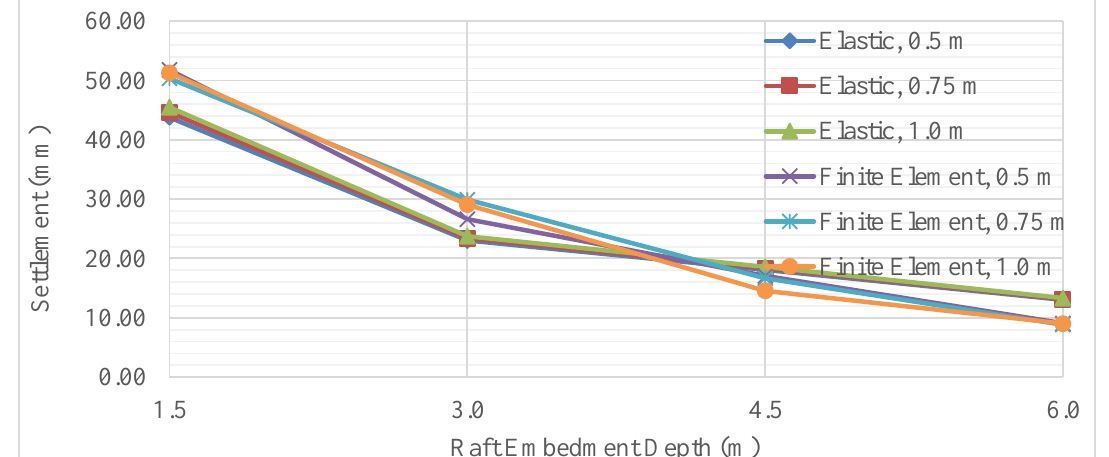
Fig. 12. Settlement versus depth showing the effect of raft thickness for 200 kN/m 2 .